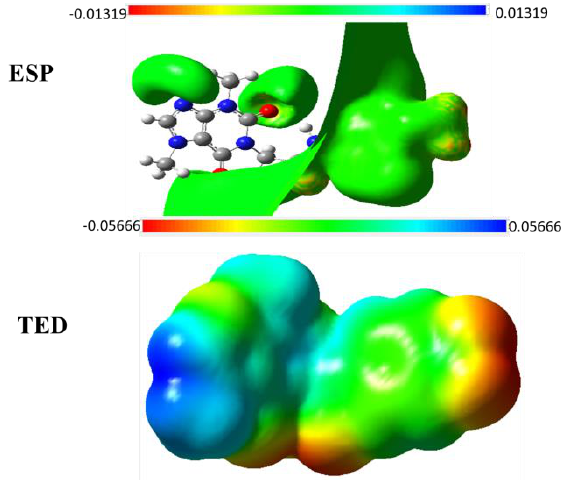
Figure 14 . TED and ESP maps of T-2-PNPA at the 6-311G++(d,p) basis